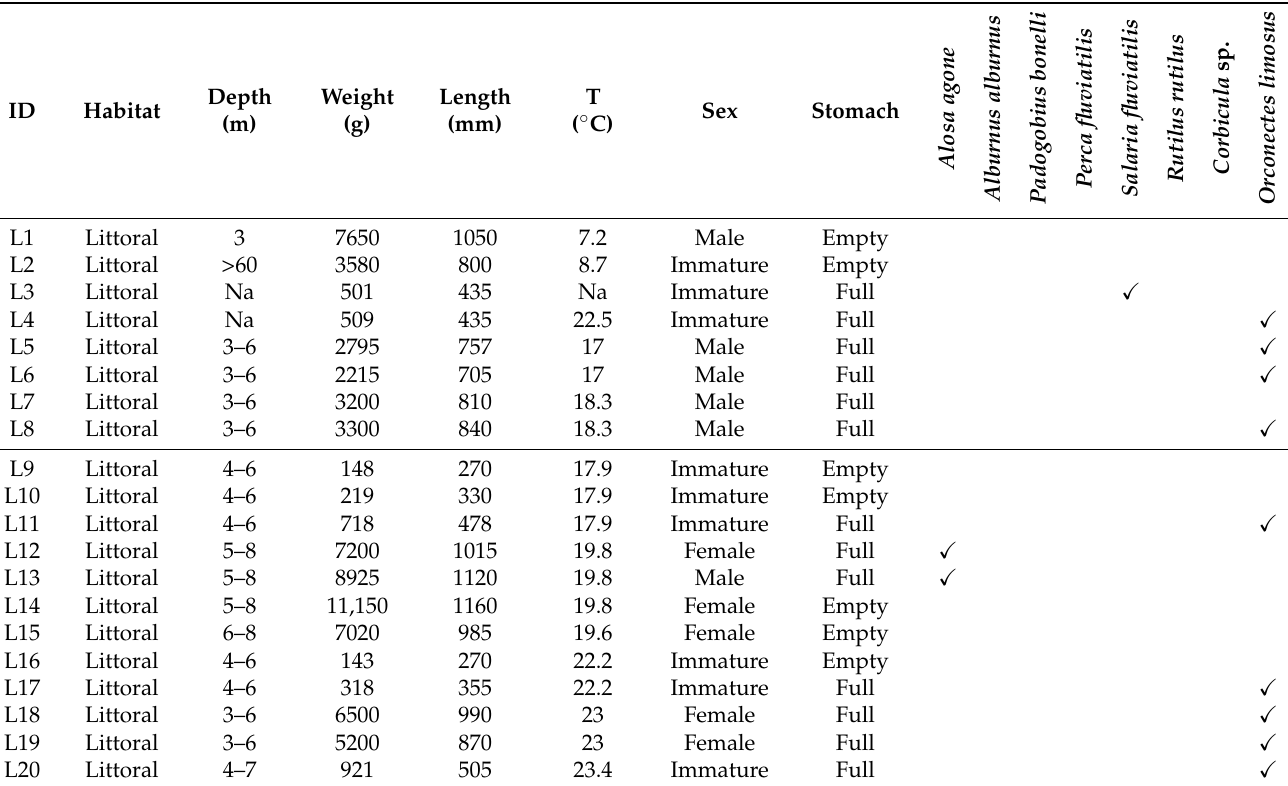
Figure 1. Sampling location in the Lake Maggiore near the town Ispra. The grey rectangle indicates the area where littoral sampling took place, whilst the white ellipse indicates the area of pelagic sampling. Table 1. Description of Siluro glanis individuals caught in this study. Name of the individual (ID), habitat of sampling, depth of sampling (metres) specimen weight (grams), specimen length (millimetres), water temperature (T), sex and stomach status, and species identified in the stomachs are